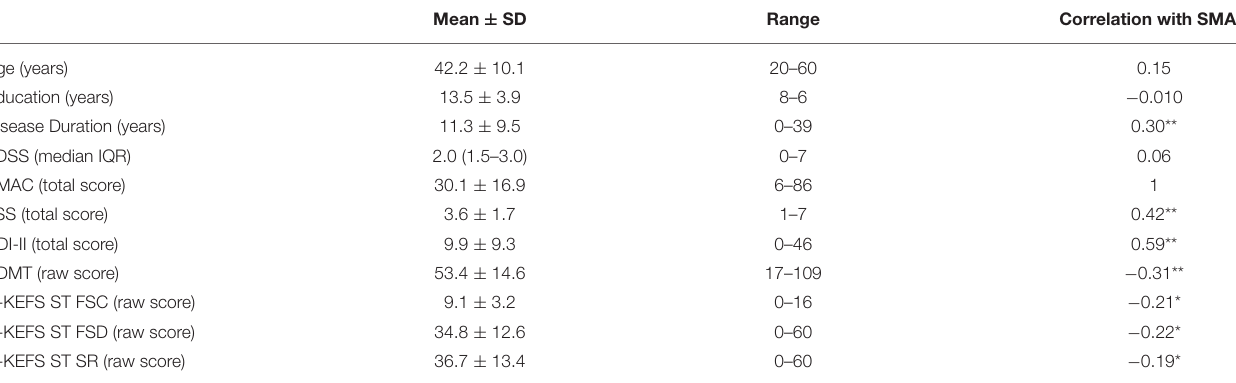
TABLE 2 | Correlations between SMAC, demographics, clinical data and neuropsychological